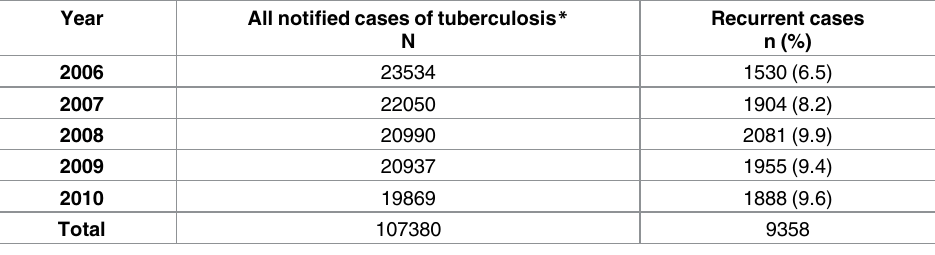
Table 1. Trends in number of all notified tuberculosis cases and recurrent casesin Uzbekistan between 2006and